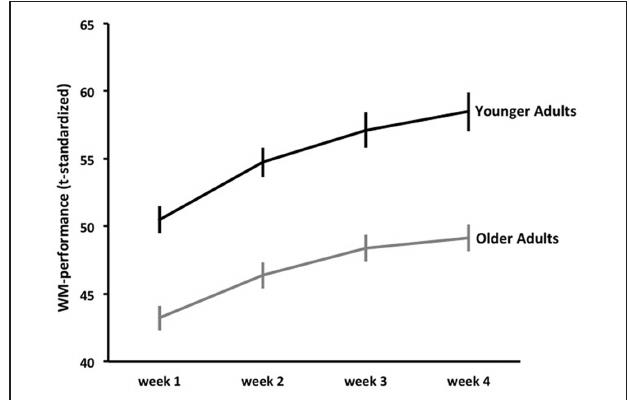
FIGURE 1 | Mean working-memory (WM) performance across 4 weeks of adaptive training. Error bars represent standard errors around the